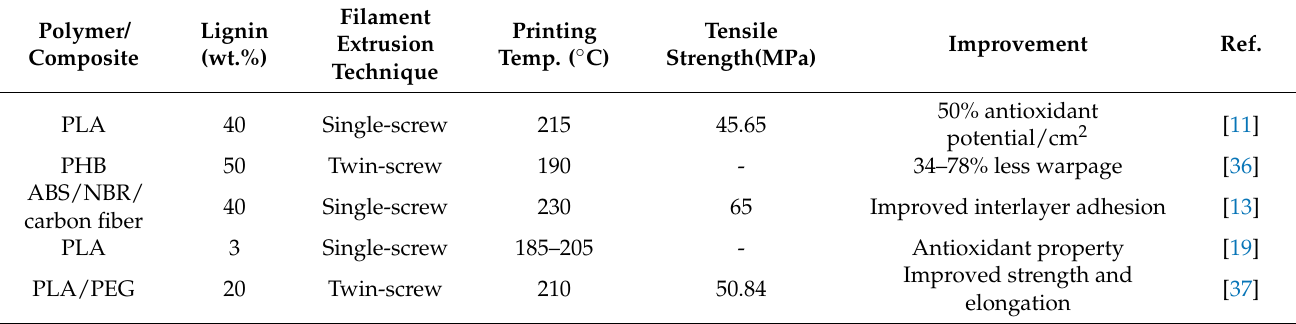
Figure 7. Linear regression between the predicted values versus experimental tensile strength val- ues during testing using the ANFIS model.